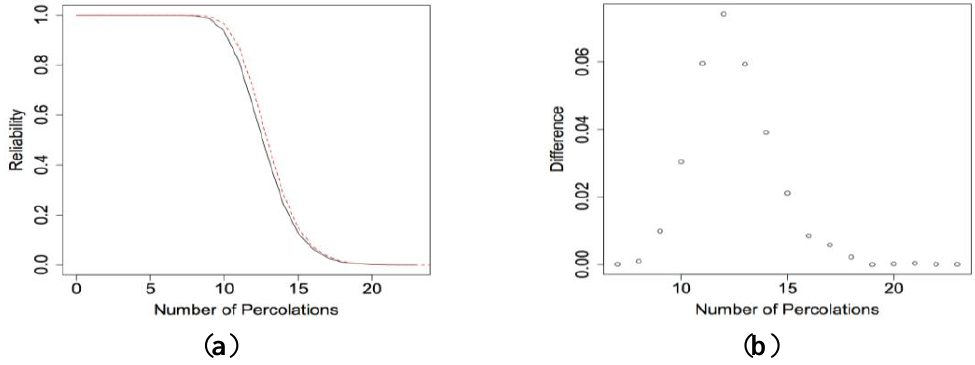
Figure 16. ( a ) R H ( x ) calculated using our algorithm when the electrical current can 7 × 5